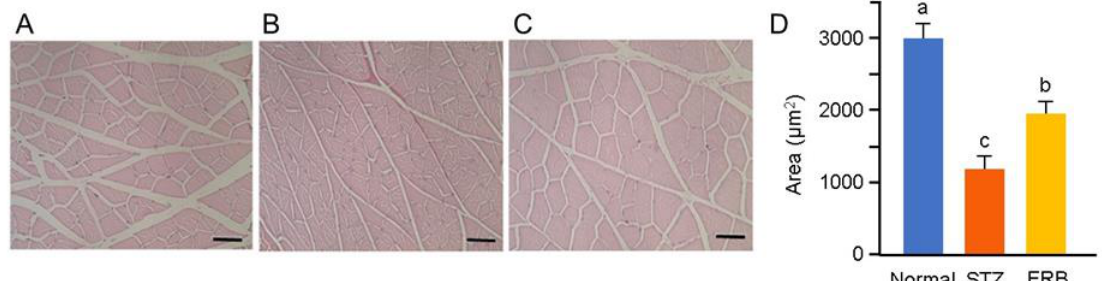
Figure 3. FRB supplementation increased the muscle size in rats with STZ-induced diabetes. Representative myocyte cross-sections of the gastrocnemius muscle of the ( A ) control, ( B ) STZ, and ( C ) FRB groups stained with hematoxylin and eosin. ( D ) The average of the myocyte cross-sectional